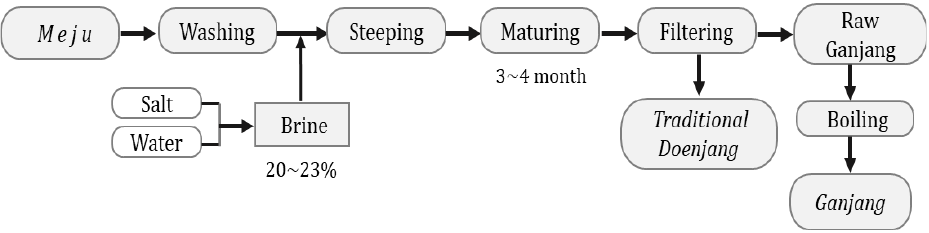
Figure 4. Schematic representation of ganjang preparation .